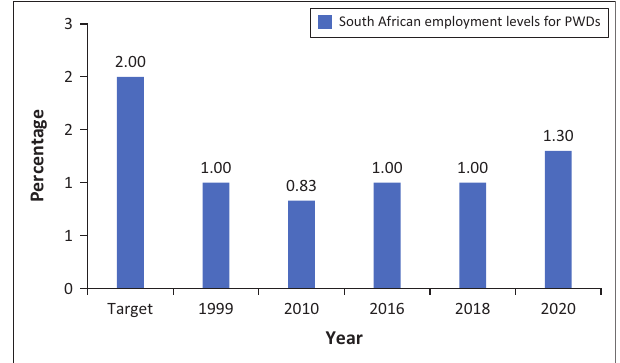
FIGURE 1 : Employment levels for persons with disabilities (synthesised from employment equity reports released annually by the Commission for Employment